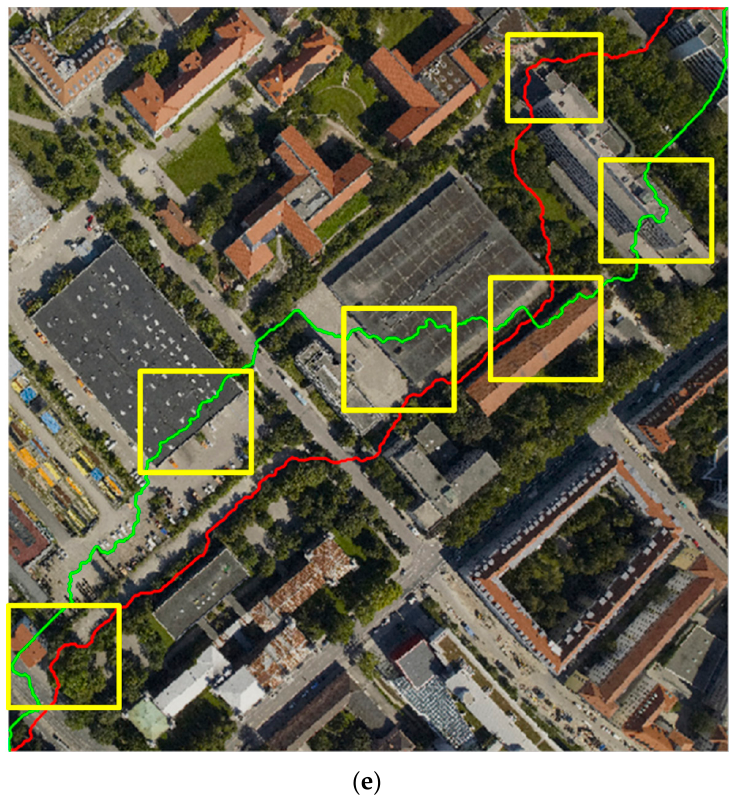
Figure 8. Experimental results of image set 2: ( a ) the left image; ( b ) the right image; ( c ) Pan’s cost; ( d ) our cost; ( e ) seamlines based on Pan’s cost (green line) and ours (red line).